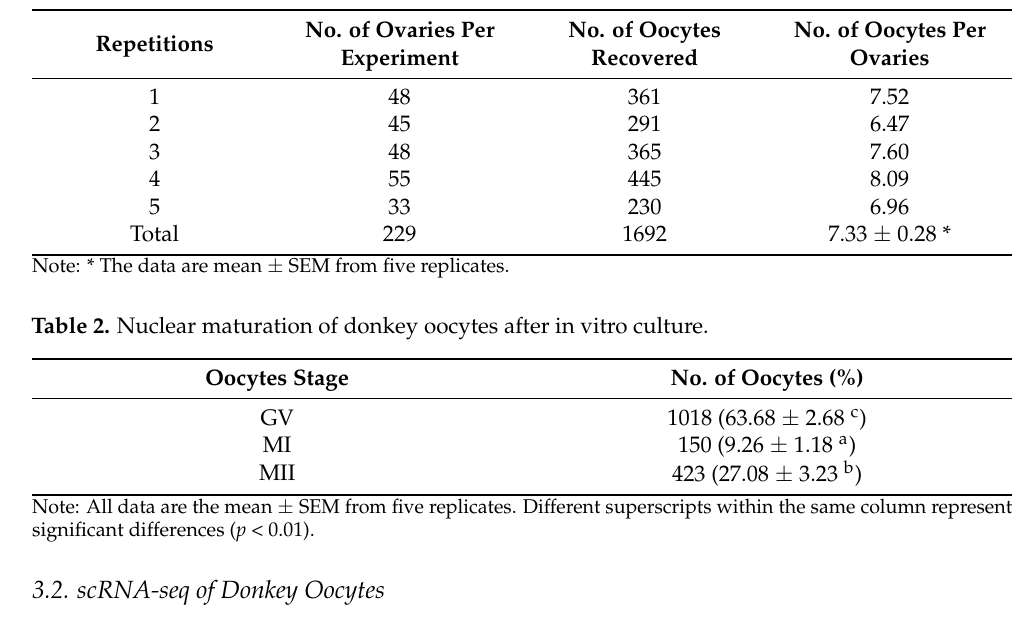
Table 1. Oocyte recovery from adult jenny ovaries by scraping.